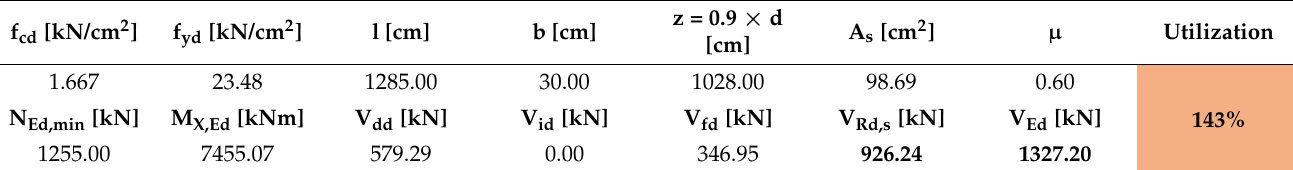
Table 9. Shear failure—validation for wall A on basement level.